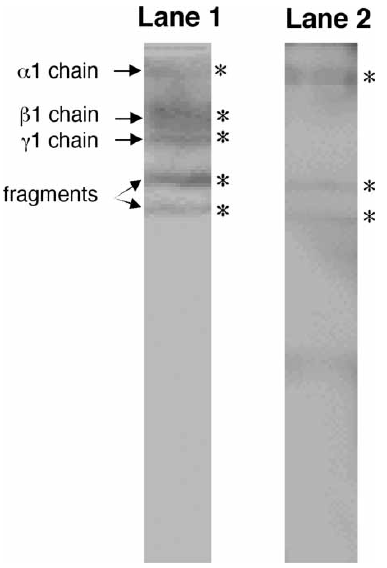
FIGURE 5 Western blot analysis of anti-laminin-1 antibodies. Laminin-1 was run on SDS-PAGE under the reduced condition and transferred on a nitrocellulose membrane. Lane 1: Serum of IgG anti- laminin-1 antibodies positive recurrent aborter. Lane 2: Purified IgM monoclonal antibody (AK-8) to